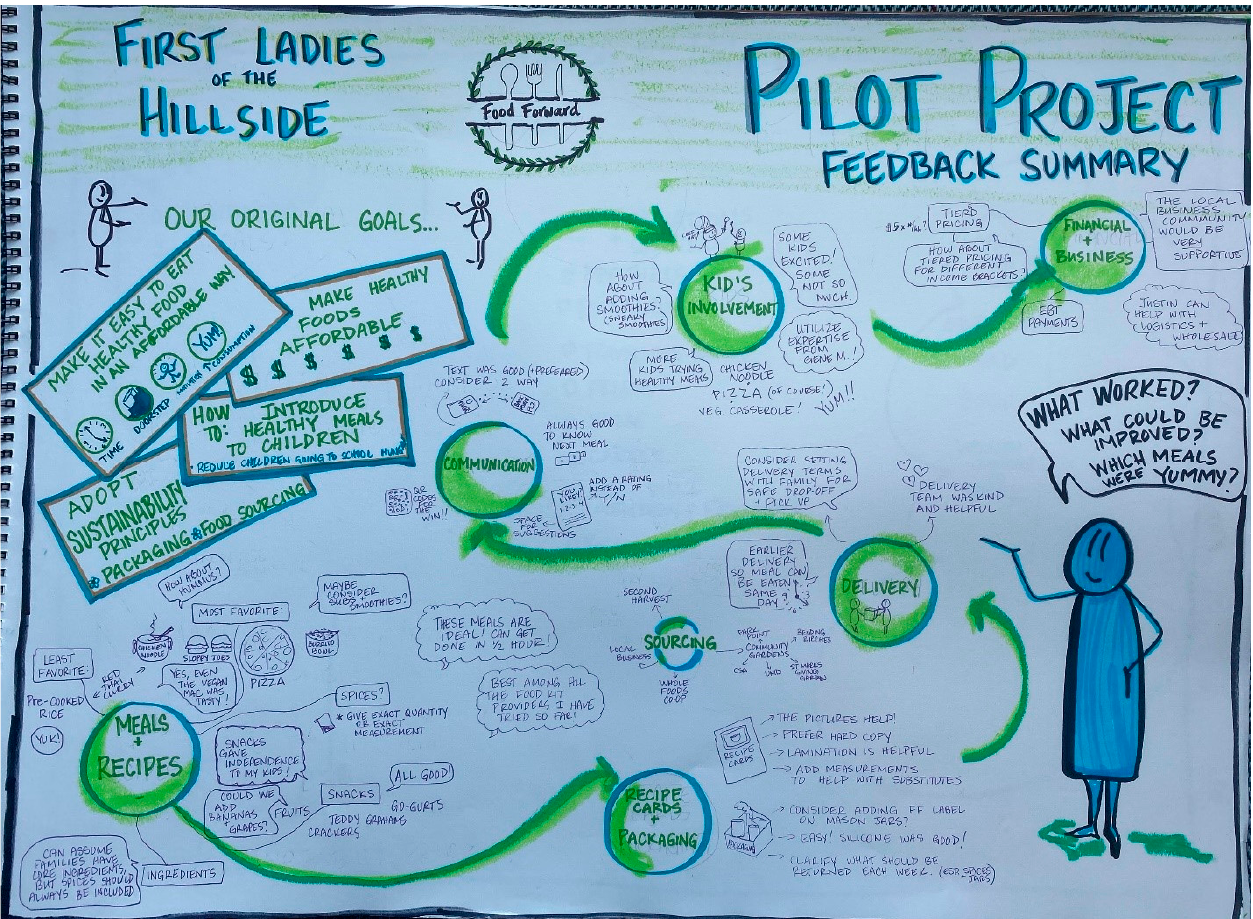
Figure 1. Graphic Recording of Focus Group 1.